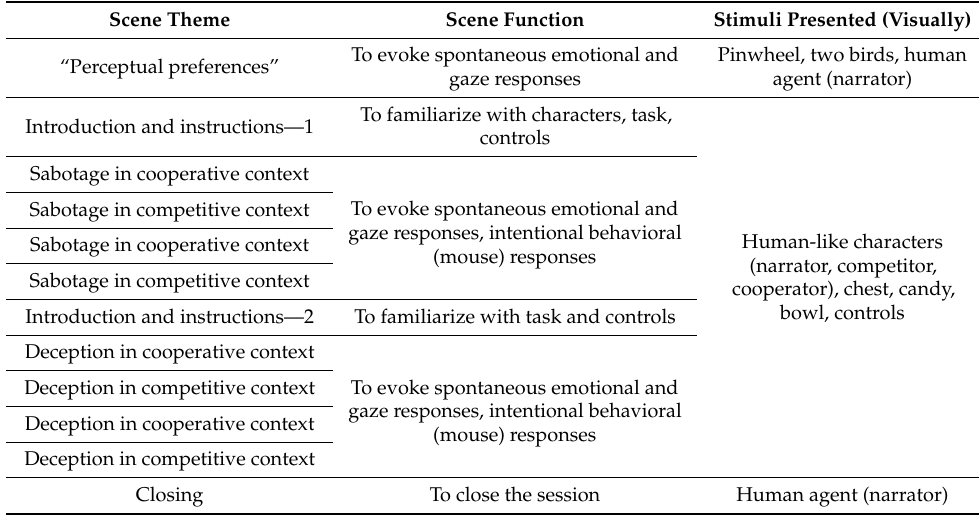
Table 2. Outline of the scene structure of the game (adapted from Gyori et al.